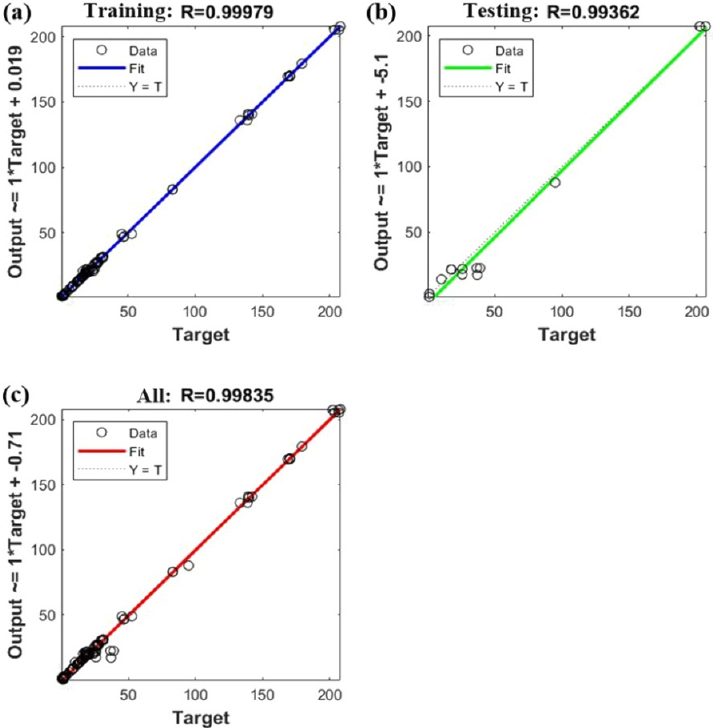
Figure 9. Regression analysis of BP neural network: ( a ) training samples, ( b ) testing samples and ( c ) all samples.